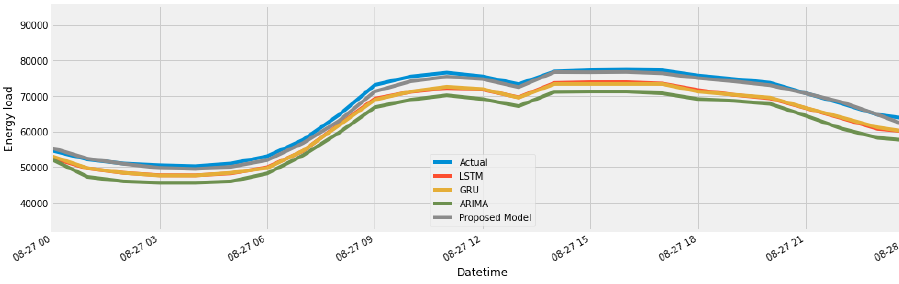
Figure 22. Comparison of purposed model with ensemble models.